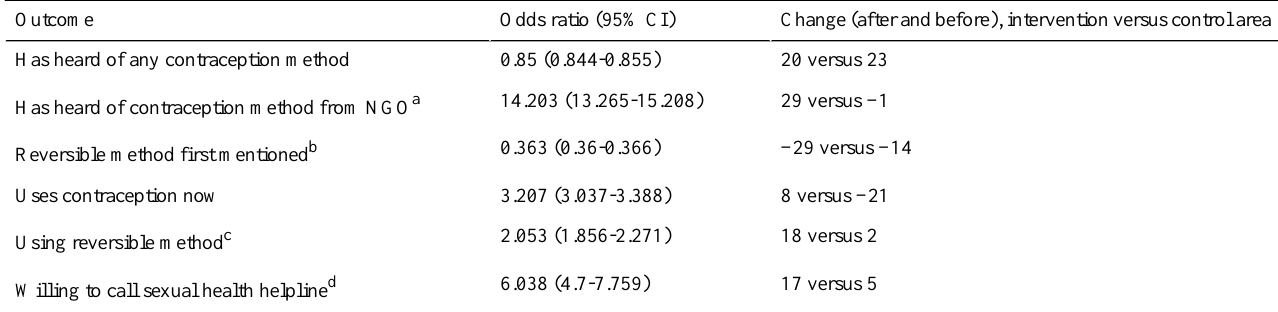
Table 3. Odds ratios (95% CIs) for interaction between intervention area and period after intervention and mean change for intervention versus control area on knowledge and practice of sexual and reproductive health (source: baseline and follow-up surveys, two primary health center areas in Maharashtra). Change (after and before), intervention versus control areaOdds ratio (95%